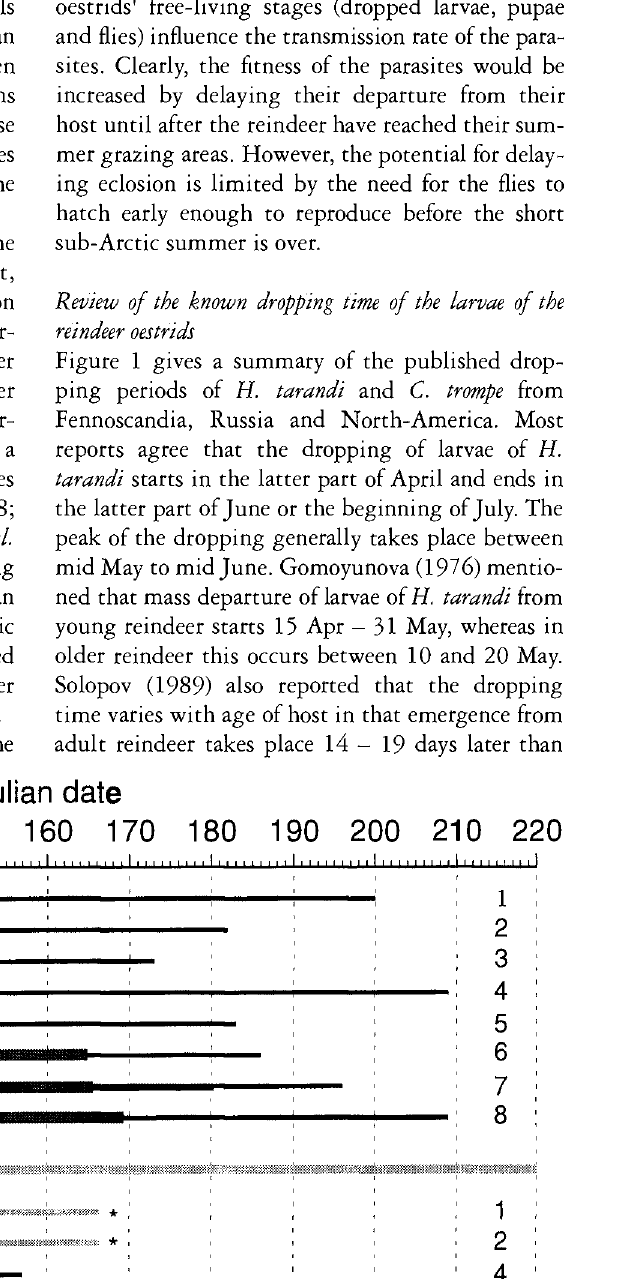
Fig. 1. Summary of published records of dropping periods of larvae of H. tarandi and C. trompe. Thicker portions of the lines denote mass departure of larvae. *: End of dropping not given. The number after each line refers to: